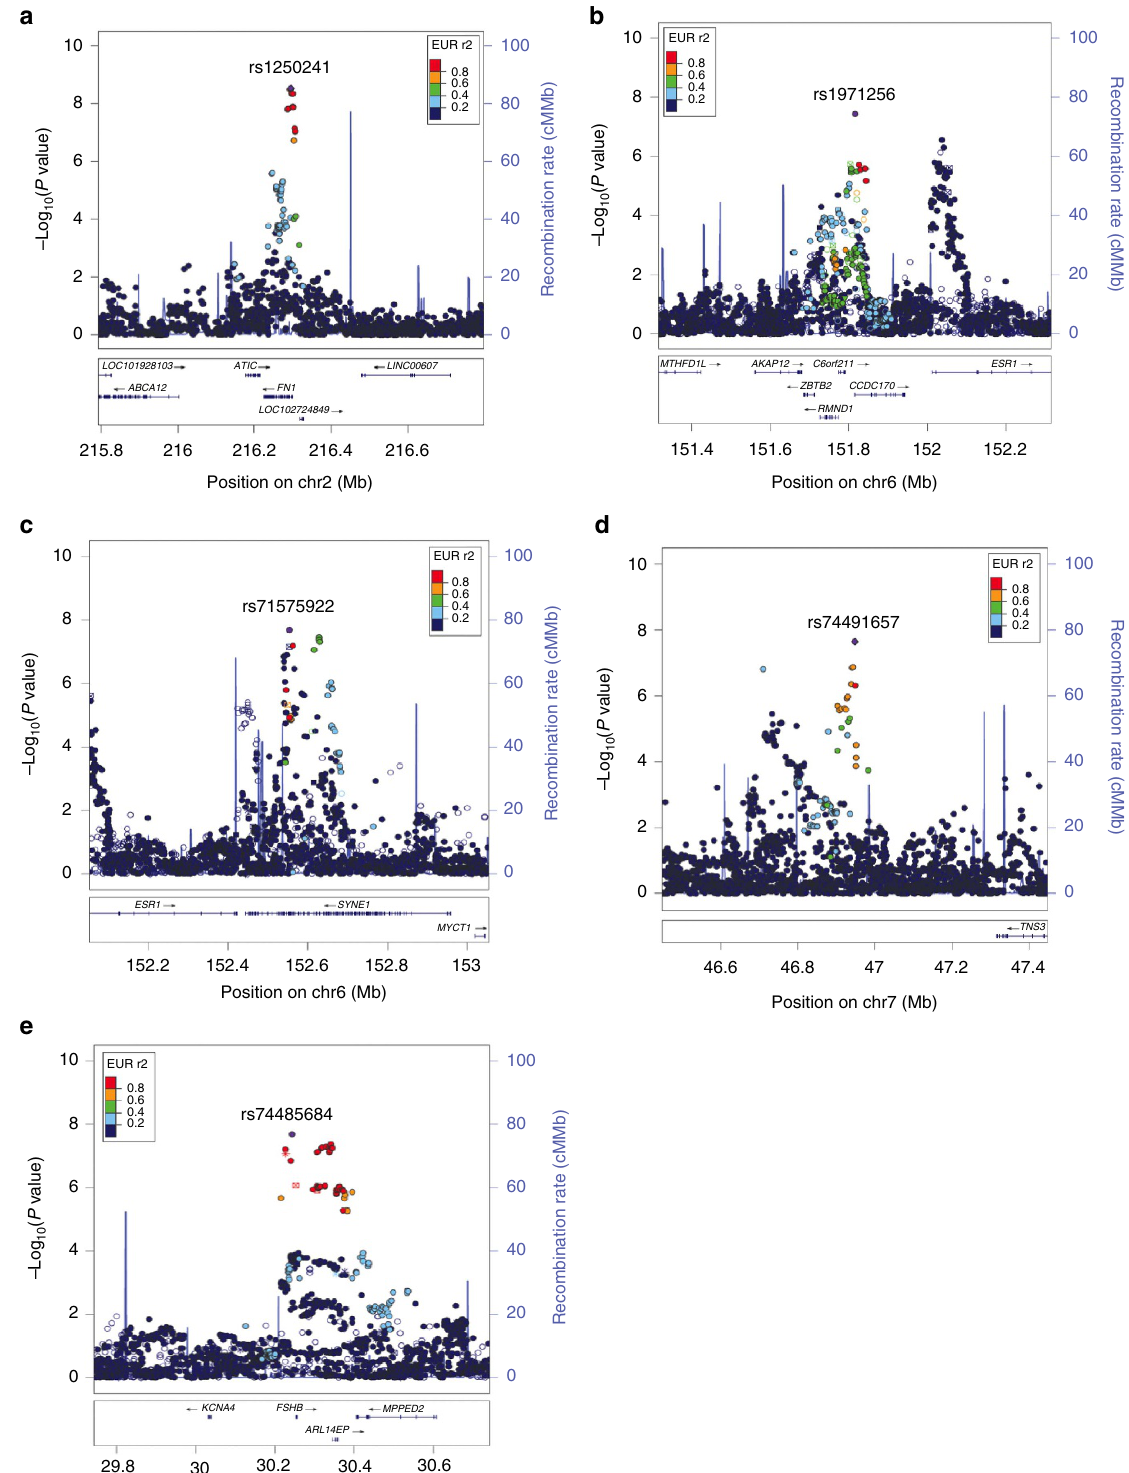
Figure 2 | LocusZoom plots of five genome-wide significant endometriosis loci. Association with endometriosis is expressed as (cid:3) log 10 ( P value) for five new genome-wide significant loci: FN1 2q35 (2a), CCDC170 on 6q25.1 (2b), SYNE1 on 6q25.1 (2c), 7p12.3 (2d), and near FSHB on 11p14.1 (2e). Results for 2q35 and 7p12.3 are based on analysis including only moderate-to-severe (’Grade B’) endometriosis cases. SNPs are shown as circles, diamonds or squares (filled or unfilled), with the top SNP represented by purple colour. All other SNPs are colour coded according to the strength of LD with the top SNP (as measured by r 2 in the European 1000 Genomes